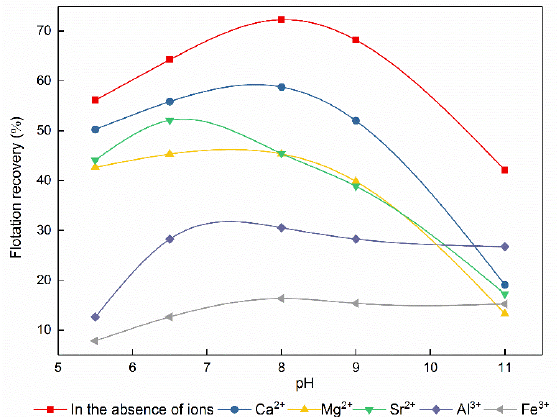
Figure 5. Influence of pH on bastnaesite flotation (Metal ion: 1 × 10 − 4 mol/dm 3 , salicylhydroxamic acid (SHA): 5 × 10 − 4 mol/dm 3 ).